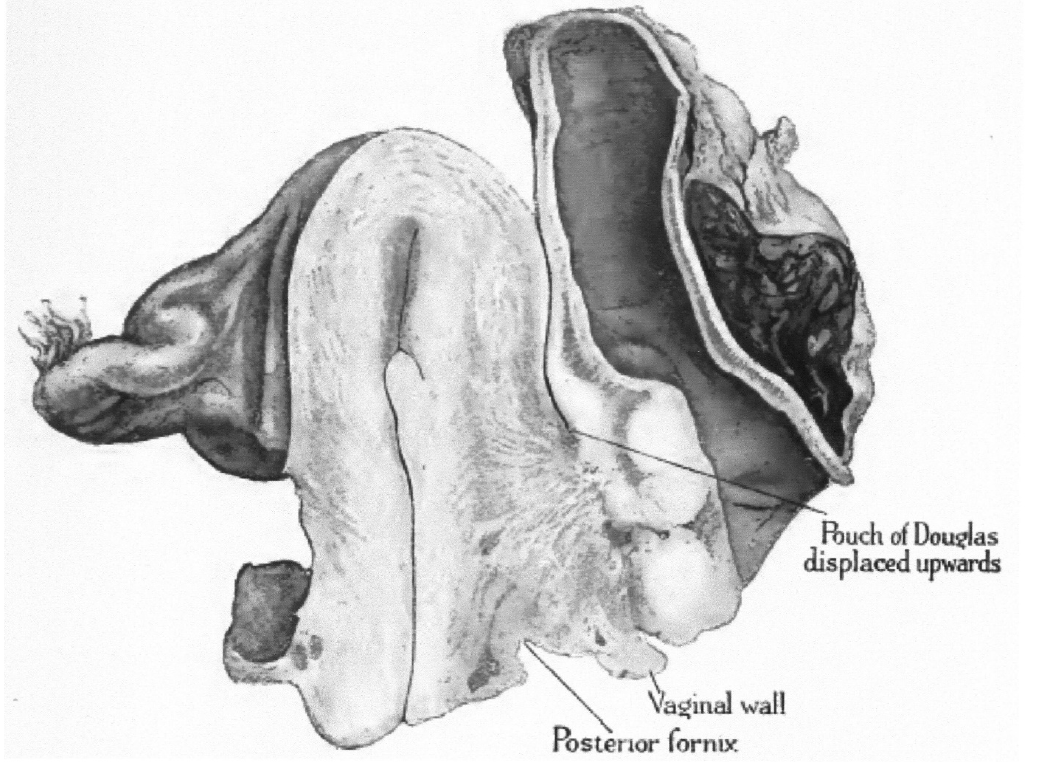
Figure 3. A case of adenomyoma of the recto-vaginal septum that exhibits adhesions between the cervix and the rectum and narrowing of the bowel. From Eden and Lockyer (1916).